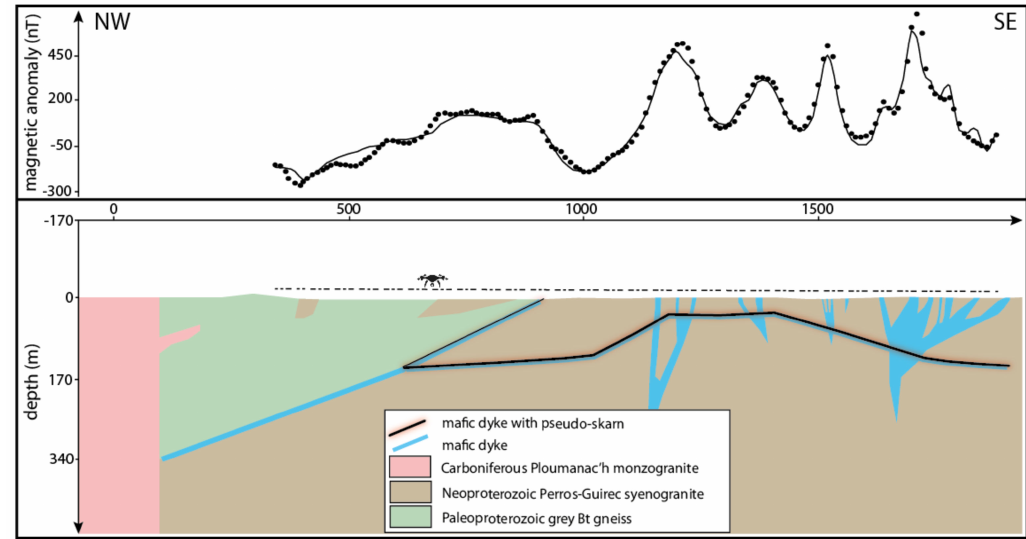
Figure 8. Local magnetic model along the coast: outcropping dykes and their actual measured magnetic susceptibility, as well as an ad hoc anastomosis at depth allow fitting the high resolution magnetic data. Upper window: UAV-borne measured magnetic anomaly (dots) compared to the computed magnetic model effect (line). Lower window: colors of modelled geological units are consistent with Figure 2.